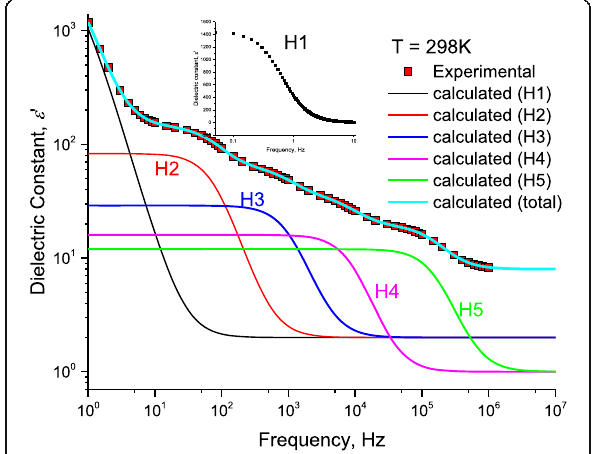
Fig. 19 The frequency dependence of measured dielectric constant ε ‘ at 298 K. One notices the presence of H1, H2, H3, H4, and H5. H1 is presented in the inset of the figure